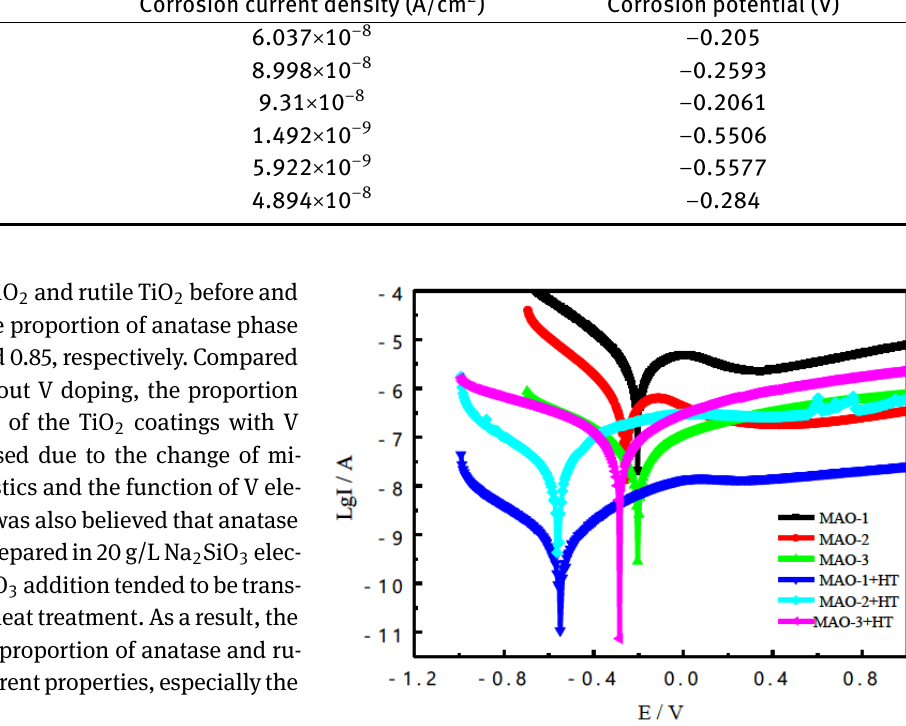
Figure 4: Polarization curves of three MAO coatings before and after heat